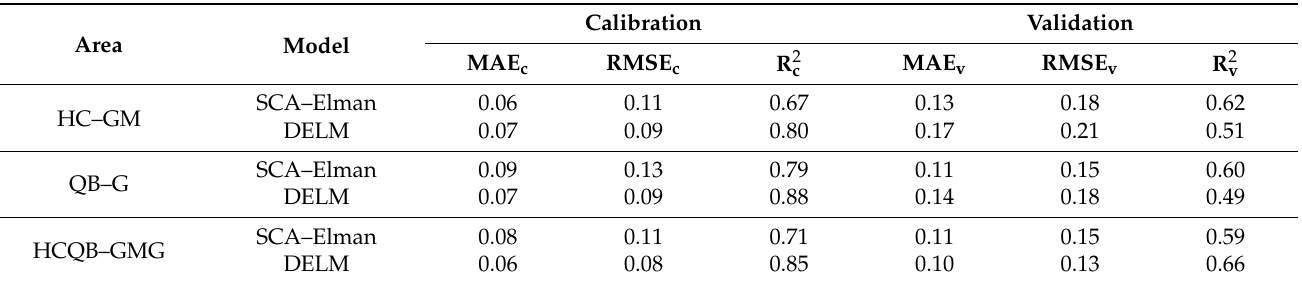
Table 6. The mean values of all of the model validation indicators for the different regions (the values of MAE and RMSE were the values after min–max